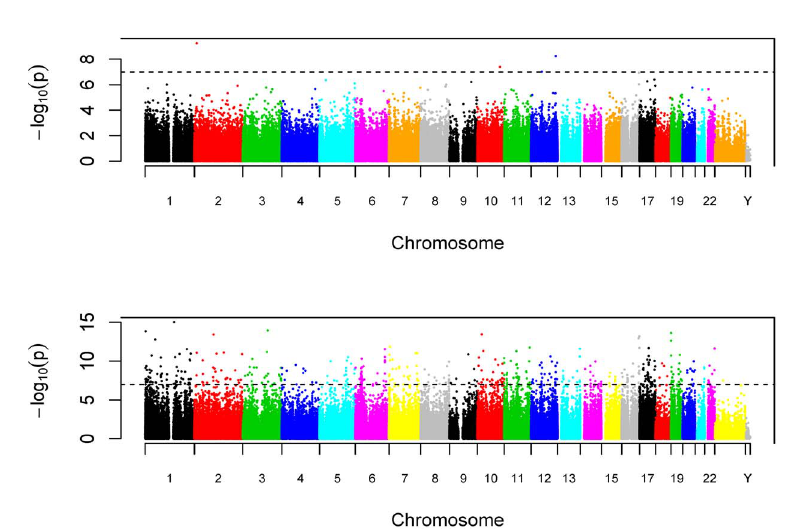
Figure 1. Manhattan plots depicting the association of all CpG sites with (A) PTB and with (B) GA. The y-axis is the negative log10 of the p-value for the association while the x-axis is position on each chromosome. The dashed line indicates experiment-wide significance. Genomic locations of each CpG site are in Table S1.